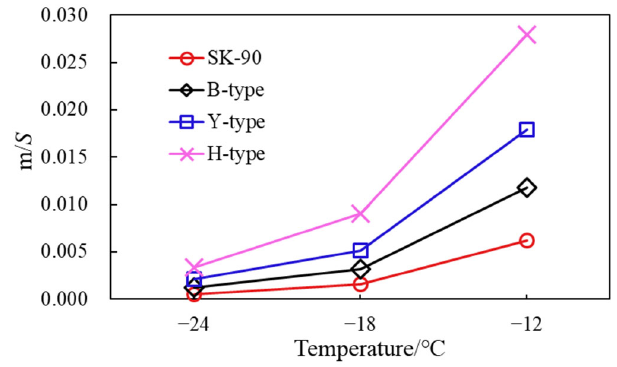
Figure 9. m/S for the di ff erent asphalt binders.